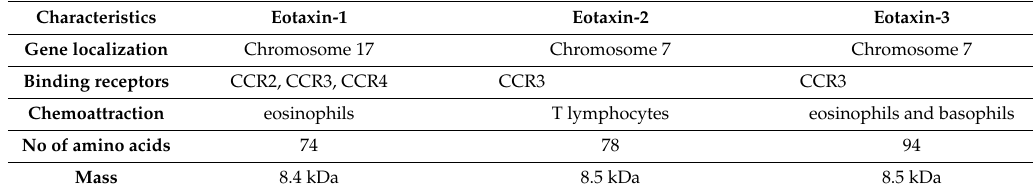
Table 2. Comparison of Eotaxins.